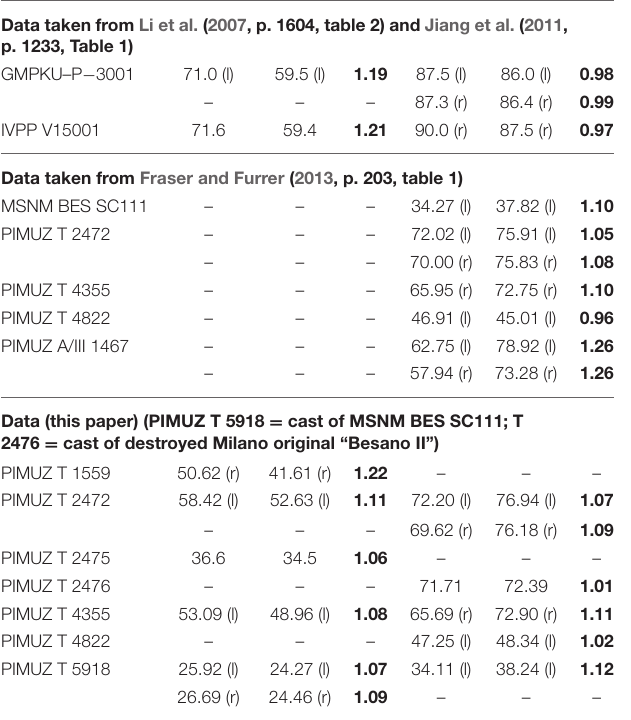
PIMUZ T 4822 Data taken from Renesto and Avanzini (2002, p. 38, table 1) MSNM BES SC111 Data taken from Li et al. (2007, p. 1604, table 2) and Jiang et al. (2011, p. 1233, Table 1)